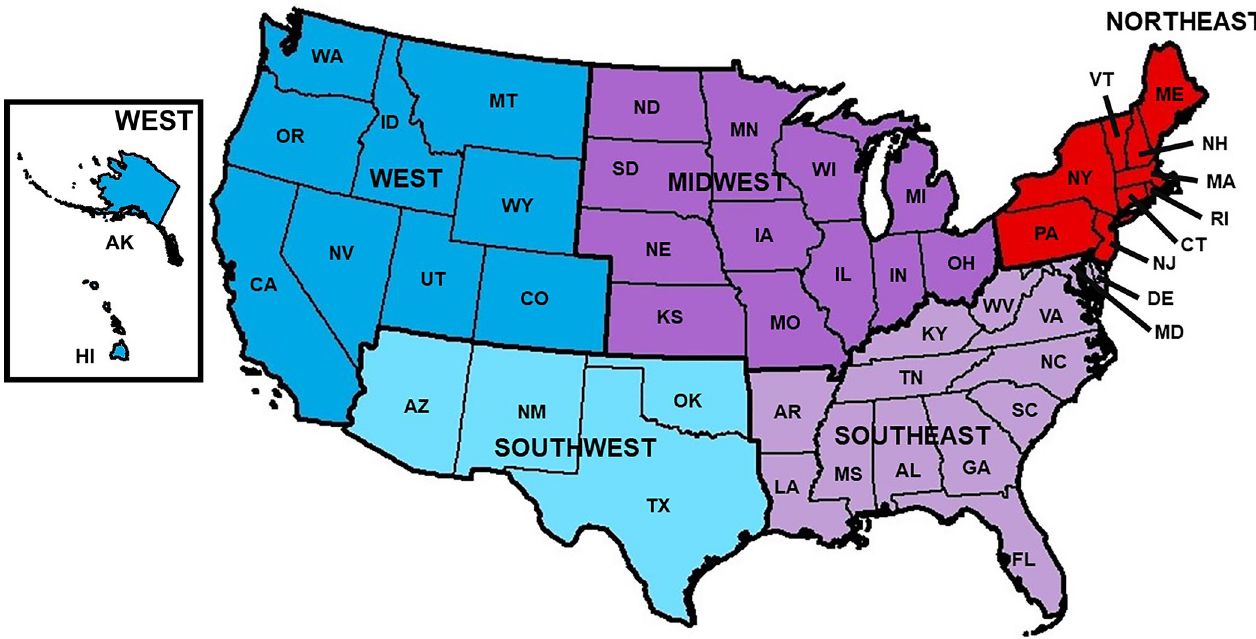
Fig 1. Regions of the United States. United States divided into 5 different regions by the geography division of the U.S. census bureau (Northeast, Midwest, Southeast, Southwest, and West) used to calculate regional Lyme incidence, and regional search term data. Map created using ArcGIS software using US census